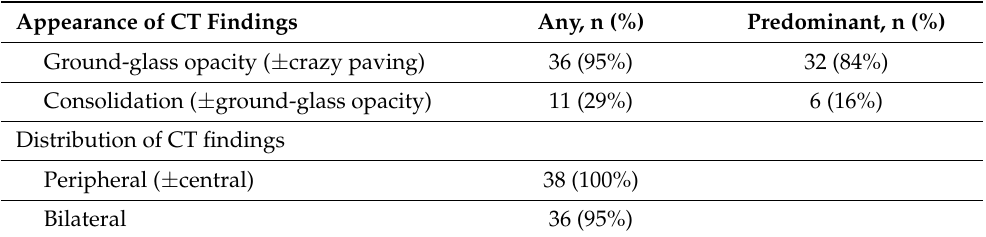
Table 2. Chest computed tomography and lung ultrasound descriptive findings. Appearance of CT